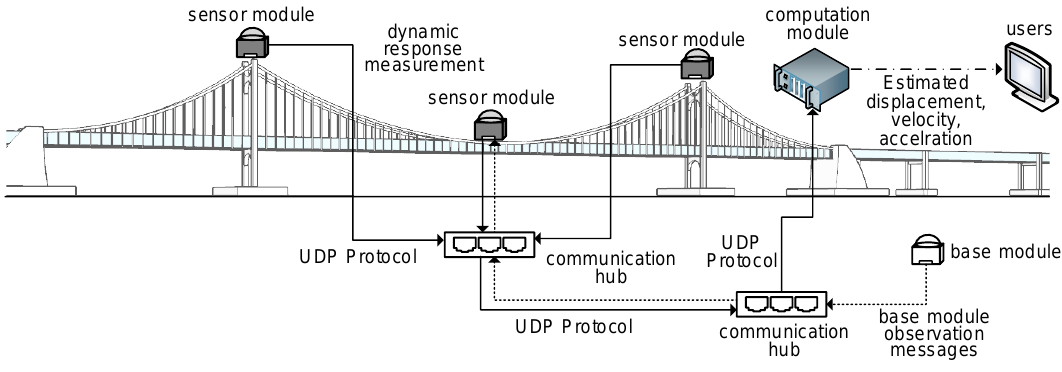
Figure 1. Overview of the proposed measurement system including sensor, base and computational modules.